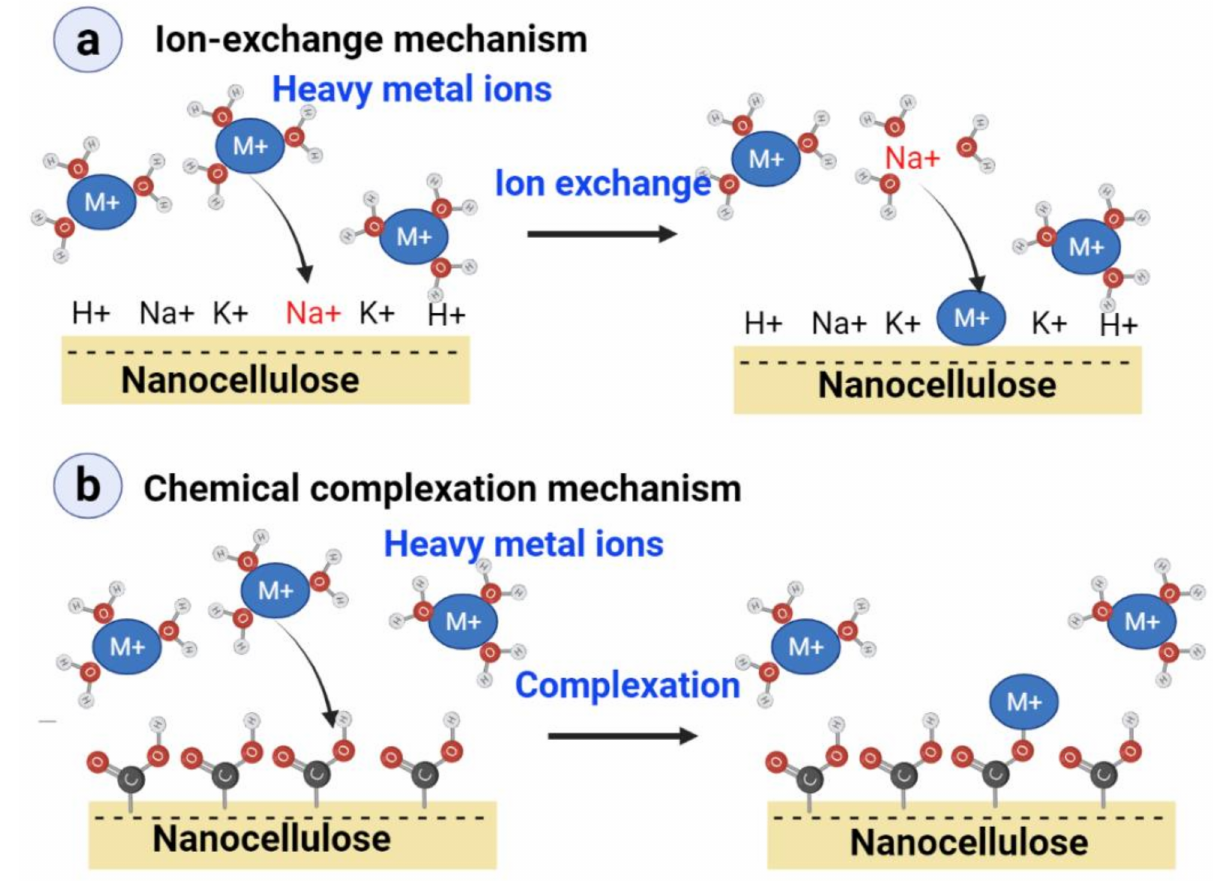
Figure 2. Heavy metal removal mechanism from water system using nanocelluloses: ( a ) Ion exchange mechanism which involves the adsorption of hazardous metal ions (M n+ ) takes the place of other ions (K + , Na + , H + ) already associated with the nanocellulose surface; ( b ) chemical complexation mechanism in which the carboxyl (-COO − ) and hydroxyl (-OH) groups of the nanocelluloses have specific site interactions with particular hazardous metal